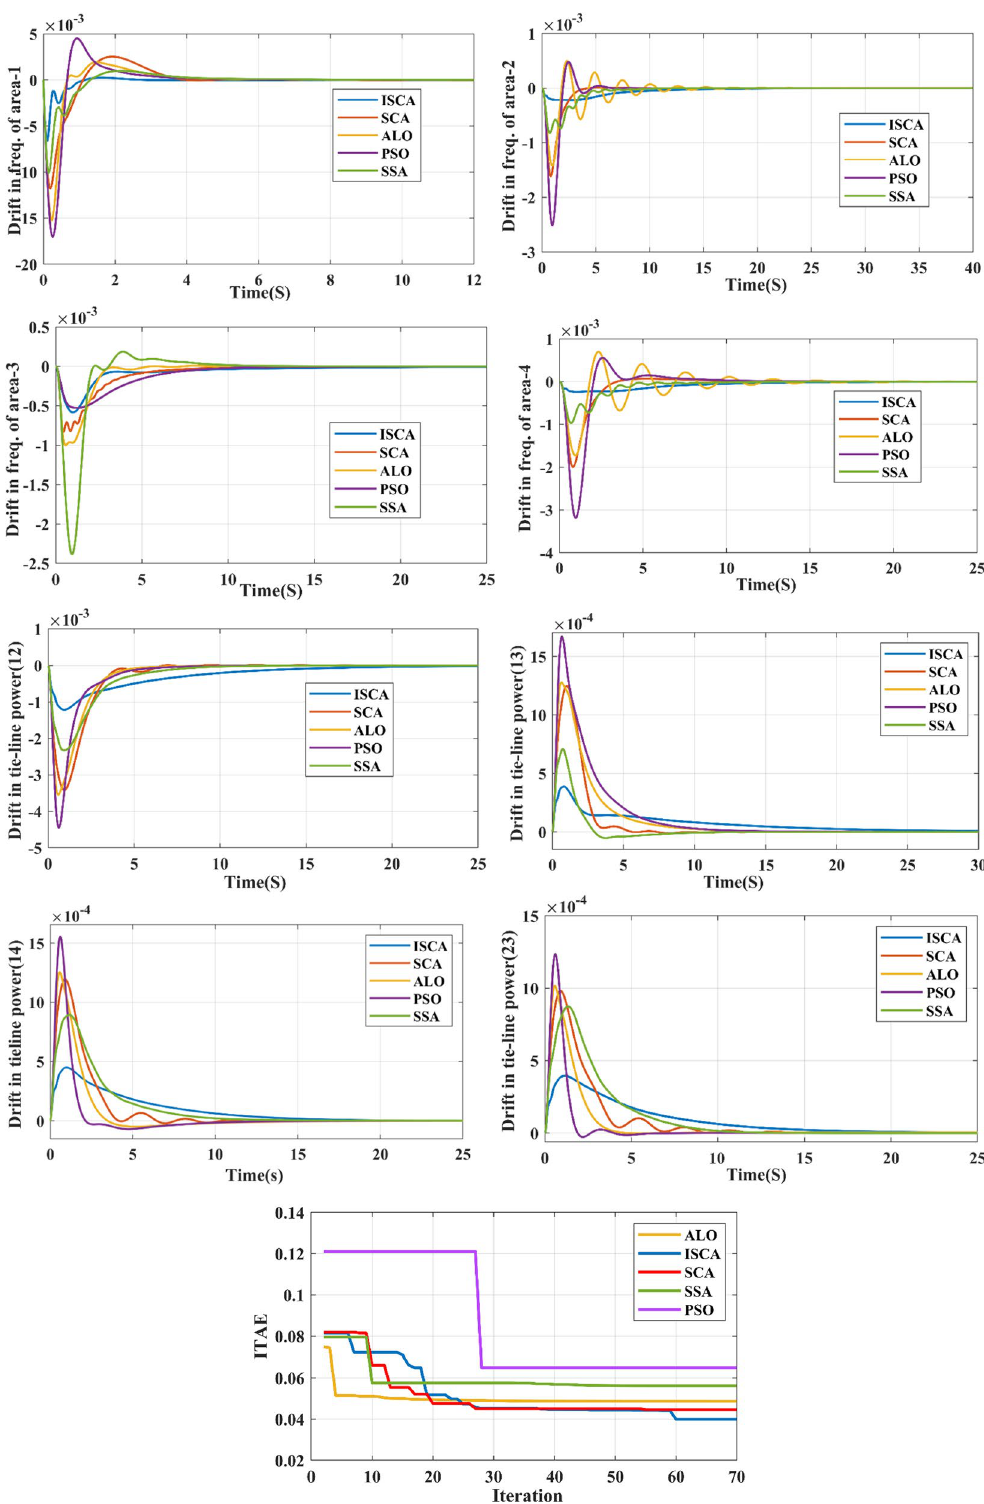
Fig. 9 Transient responses of frequency and tie-line power of all areas and convergence curves of the various algorithms for the four-area system with SLD of 2% in area-1 with the proposed and other